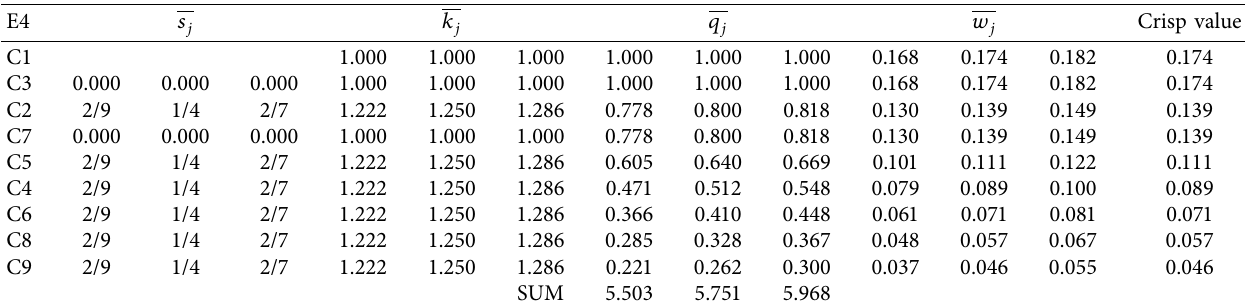
Table 6: Calculation and values of weight coefficients obtained by the IMF SWARA method for E4.